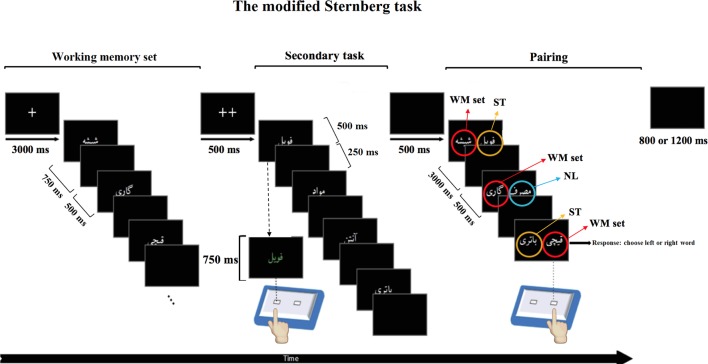
Modified Sternberg task with interference.This Figure is an example of one trial with different responses at different steps of the modified Sternberg task with interference. The modified Sternberg task with interference consisted of three steps. The first step shows a working memory set with three Persian words, out of which one is a methamphetamine-related word (e.g., methamphetamine) and two are non–drug-related words (e.g., cart and scissors). This step is considered as an encoding step. The second step illustrates the secondary task in which the color of the words can change to green or blue (interference step). Subjects have to respond to the color of the word by pressing the corresponding button on the response box (e.g., left for green, right for blue). During the last step, called the pairing step, the participants have to choose the correct word from the working memory set by using the response box (according to their position on the screen; recall step). Numbers represent the display time of the words on the screen (Figure is modified from (48).